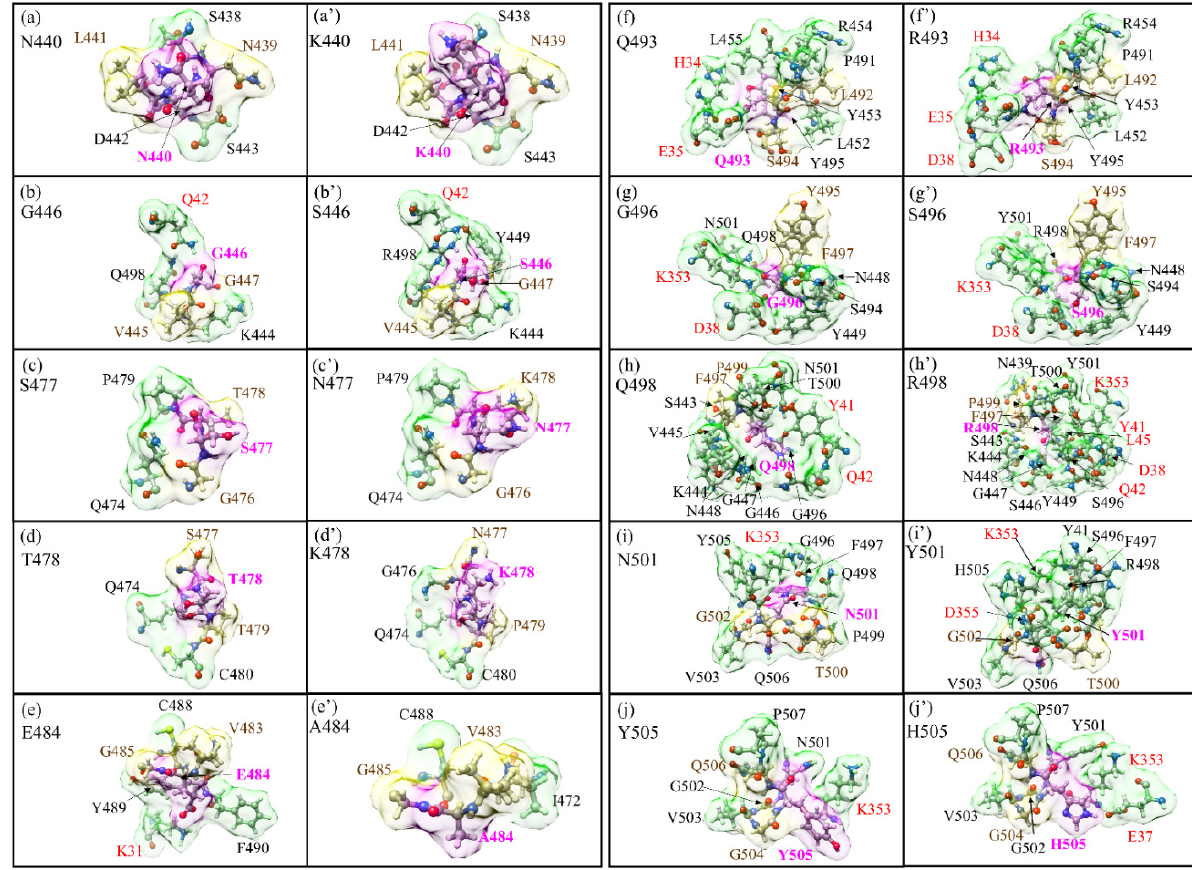
Figure 2. Details of the shape change of AABPU of the ten mutation sites in RBM: ( a ) N440, ( b ) G446,